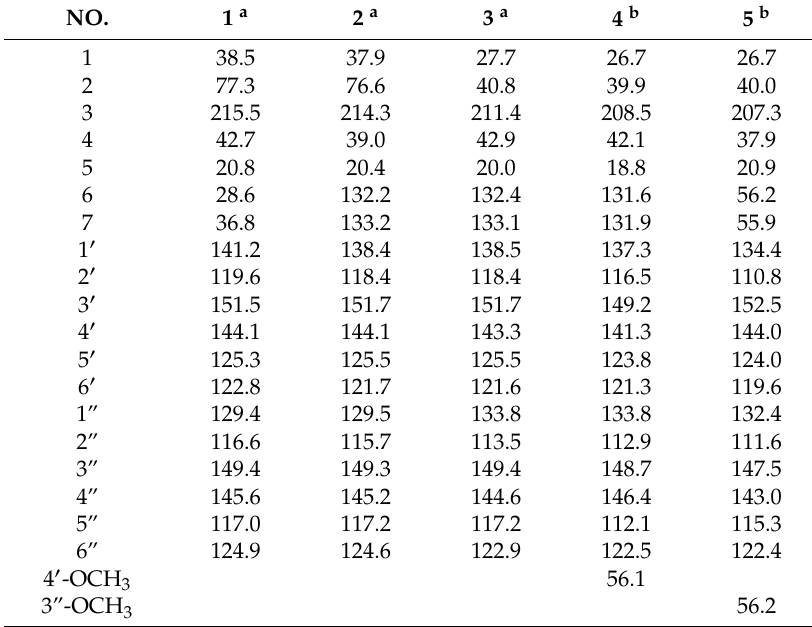
Table 2. The 13 C-NMR (150 MHz) data of compounds 1 – 5 , δ C in ppm